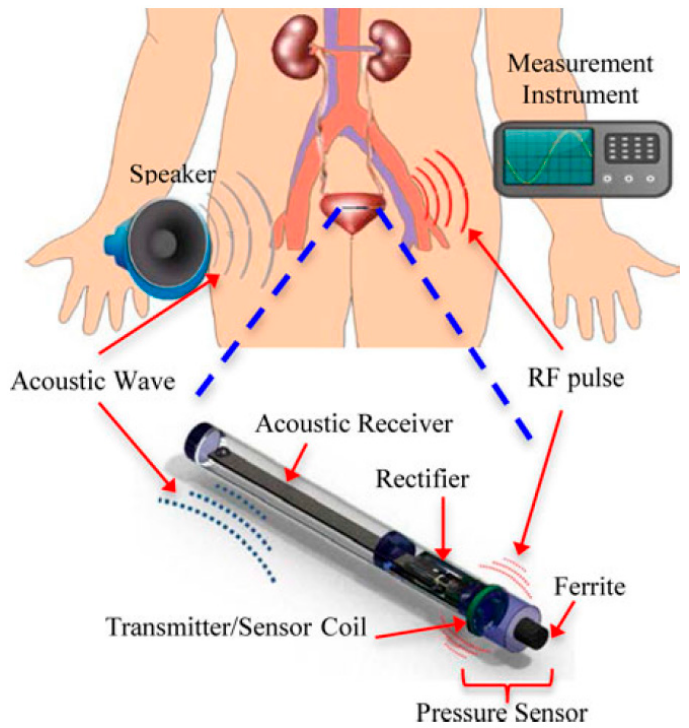
Figure 46. Schematic of APT LC transponder implanted in the bladder [203]. Copyright © 2014, IEEE. Sensors 2020 , 20 , x FOR PEER REVIEW